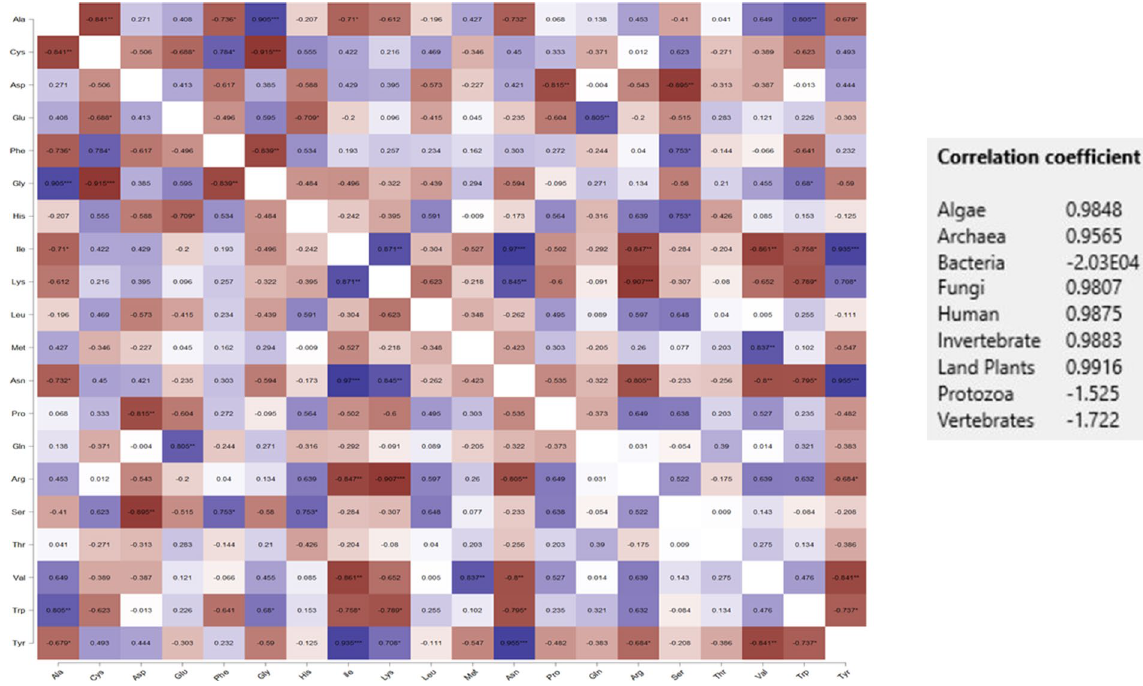
Figure 4. Correlation heat map of the composition of viral amino acid originated from different hosts. The maximum of the amino acids showed a negative correlation (red) whereas only a few amino acids showed a positive correlation (blue). The protein sequences of the virus originated from host land plants showed a positive correlation coefficient (0.9916) whereas protein sequences of the virus originated from bacteria showed a negative correlation (− 2.03E04). Pearson’s correlation study was conducted to construct the correlation plot (p <